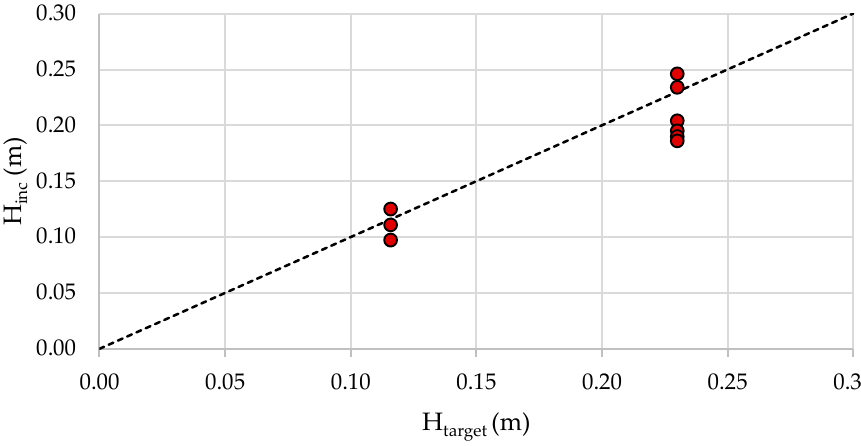
Figure 5. Comparison of target and measured incident wave height.